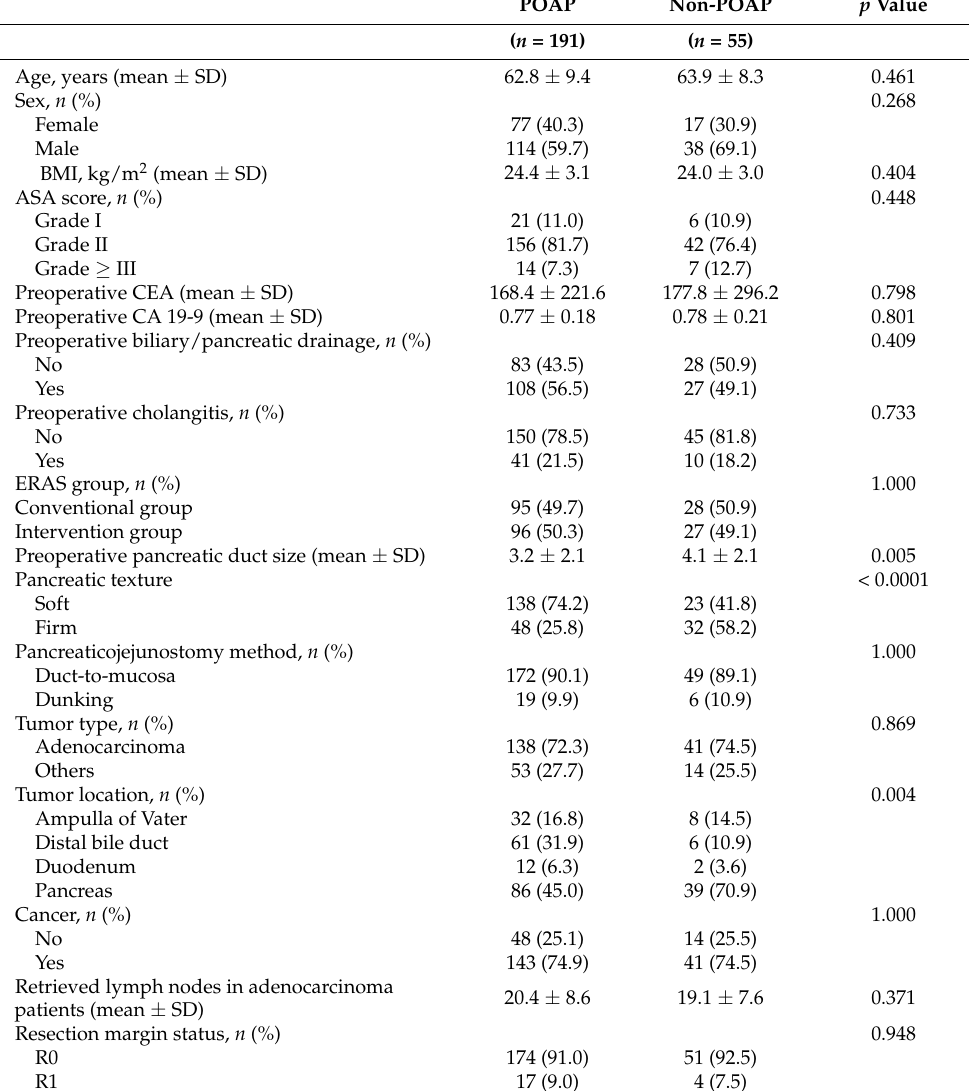
Table 1. Demographic characteristics and preoperative factors.